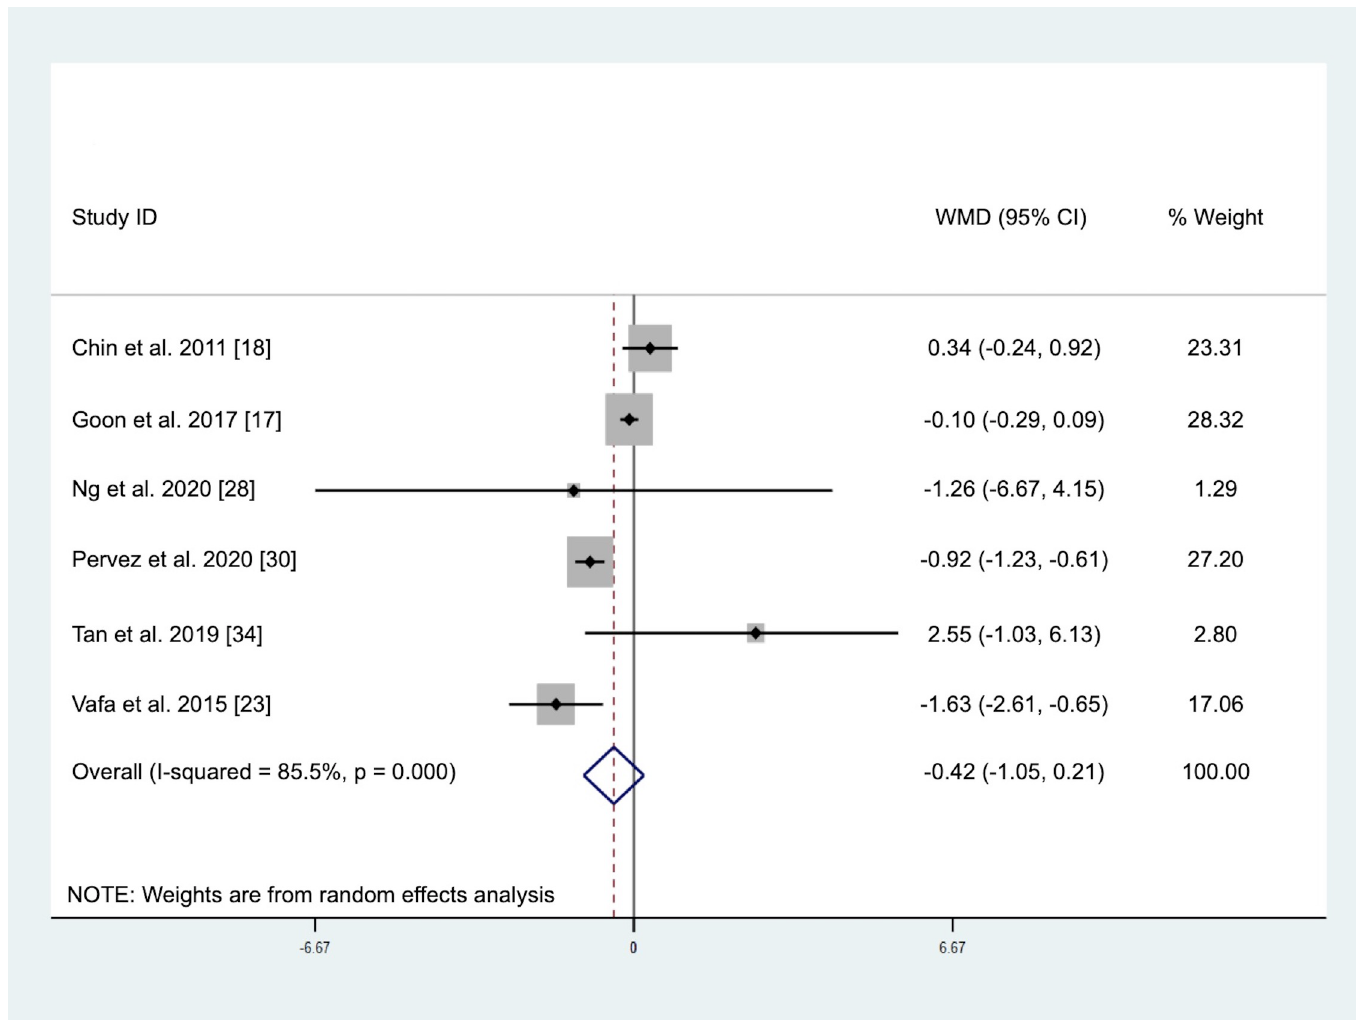
Fig 5. Forrest plot on the effect of tocotrienols supplementation on malondialdehyde levels.